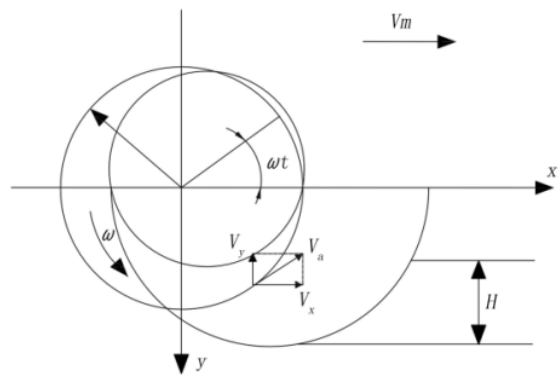
Figure 3. Rotary cutter end-point trajectory.